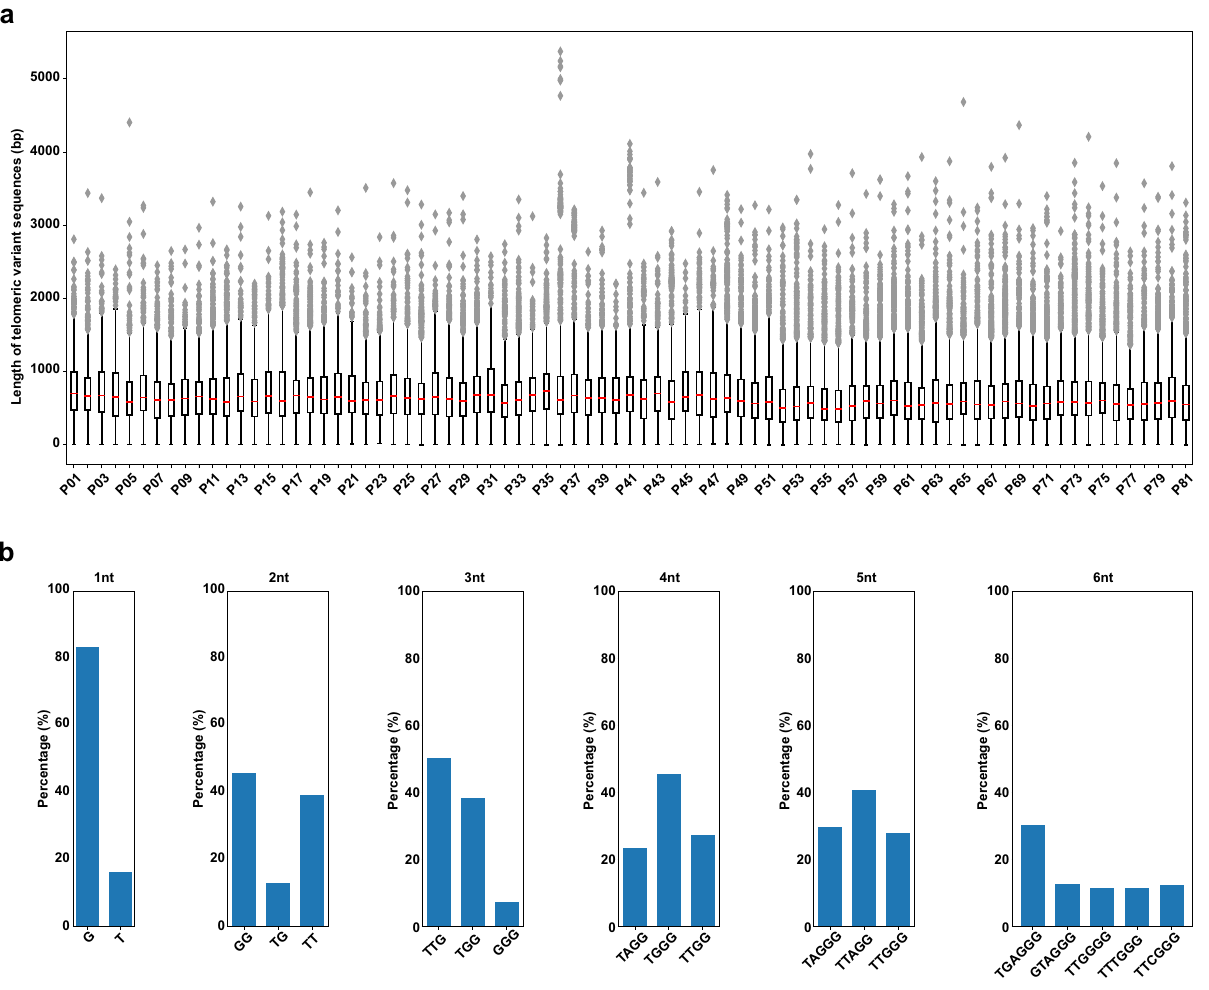
Fig. 4 | The unique length distribution and sequence of telomeric variant sequences (TVSs) in patient PBL samples. a Boxplots showing the length dis- tribution of TVSs within the telomere repeat region that is unique to each PBL sample.Please refer to the Source Data 2 fi lefor the n valueofeachsample.Within each box, the red center line denotes the median value, the bounds of box repre- sent the 25th to 75th percentile values, the whiskers represent adjacent values within 1.5 interquartile range, the ends of the whiskers depict the minimum and